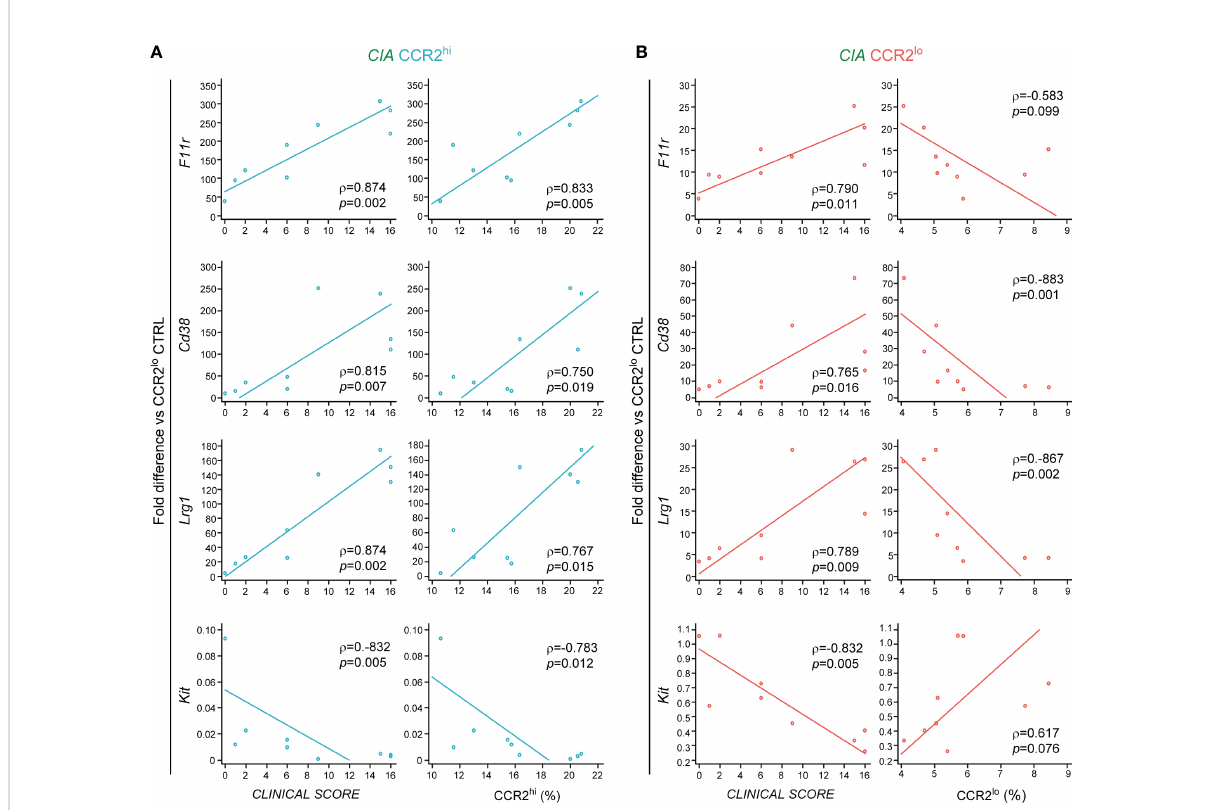
FIGURE 5 Associations of genes used as disease markers with the clinical score and size of osteoclast progenitor (OCP) subsets in collagen-induced arthritis (CIA). RNA was extracted from sorted CCR2 hi and CCR2 lo OCP subsets, reversely transcribed to cDNA and validated by qPCR in CIA group (n=9). Gene expression was normalized to the Hmbs housekeeping gene and presented as fold difference relative to the calibrator sample (cDNA from CCR2 lo subset of the control group, day 0). (A) Correlations between relative gene expression and the clinical score of arthritis, and between relative gene expression and frequency of CCR2 hi OCPs in CIA. (B) Correlations between relative gene expression and the clinical score of arthritis, and between relative gene expression and frequency of CCR2 lo OCPs in CIA. Percentages of CCR2 hi and CCR2 lo subsets are calculated out of CD45 + Ly6G - population. Individual values and trend lines are presented with the Spearman ’ s rank correlation coef fi cient ( r ). Statistically signi fi cant difference was determined at